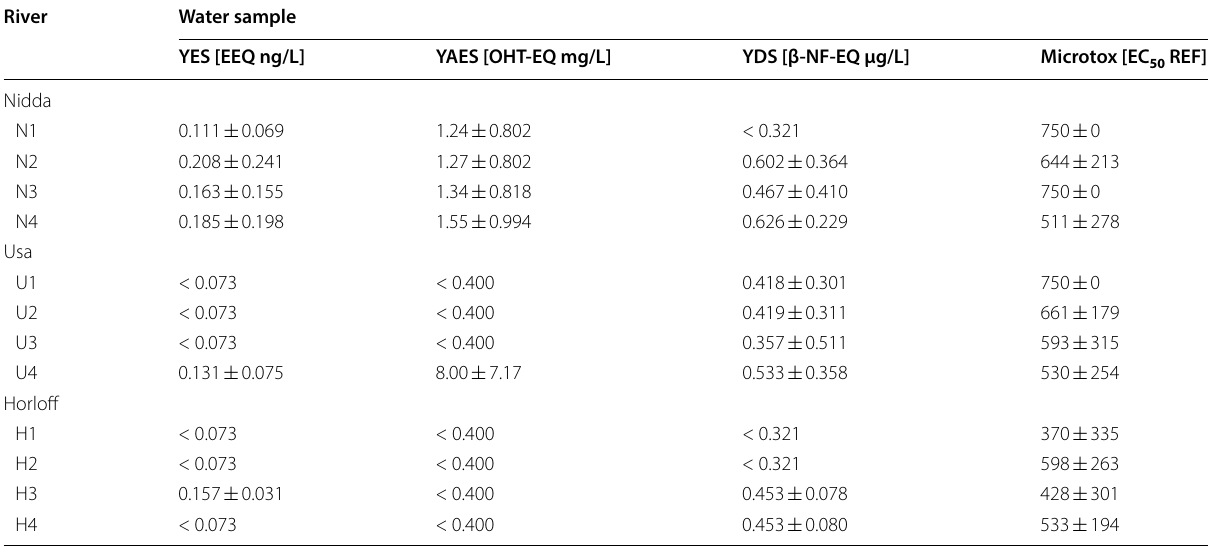
For non-toxic water samples in the microtox assay the EC 50 threshold value is 750 REF